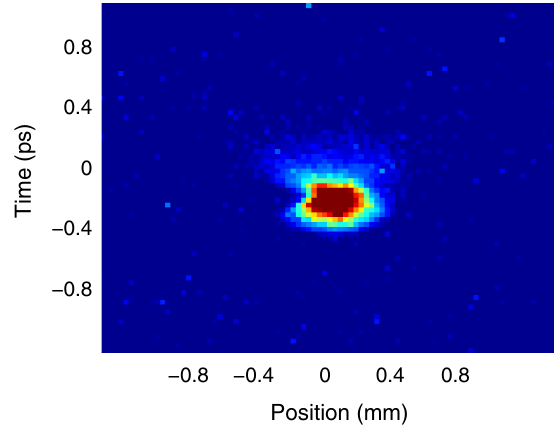
FIG. 18. The x - t plane for a highly compressed low charge beam (60 pC). A nonlinear correlation is visible despite the low